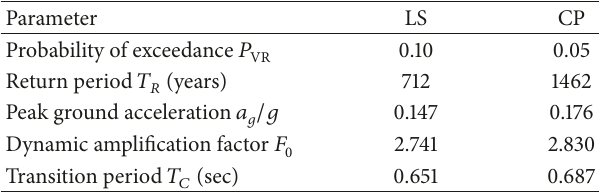
Table 2: Parameters of the elastic response spectra, in terms of acceleration for the LS and CP Limit